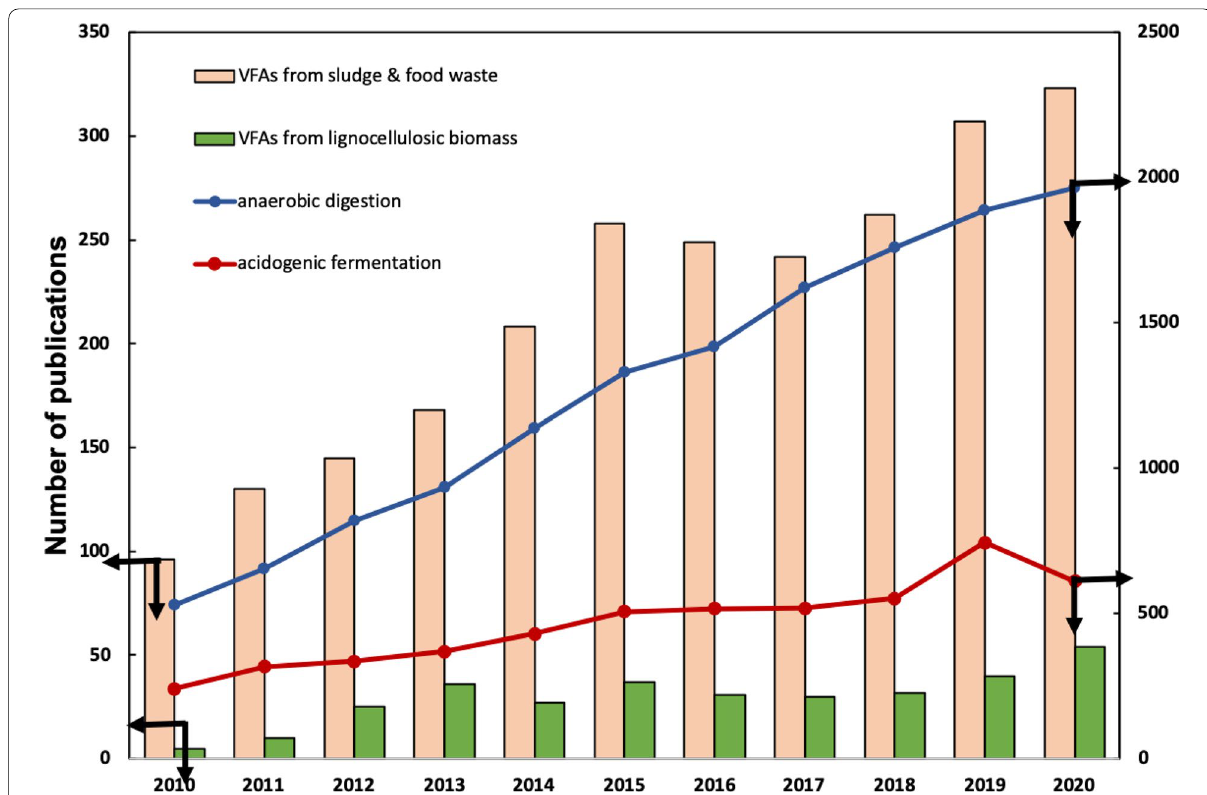
Fig. 1 Number of annual publications from 2010 to 2020 on “anaerobic digestion”, “volatile fatty acid OR acidogenic fermentation”, “volatile fatty acid OR acidogenic fermentation AND (food waste OR sludge)” and “volatile fatty acid OR acidogenic fermentation AND lignocellulos*” (based on search results in Scopus